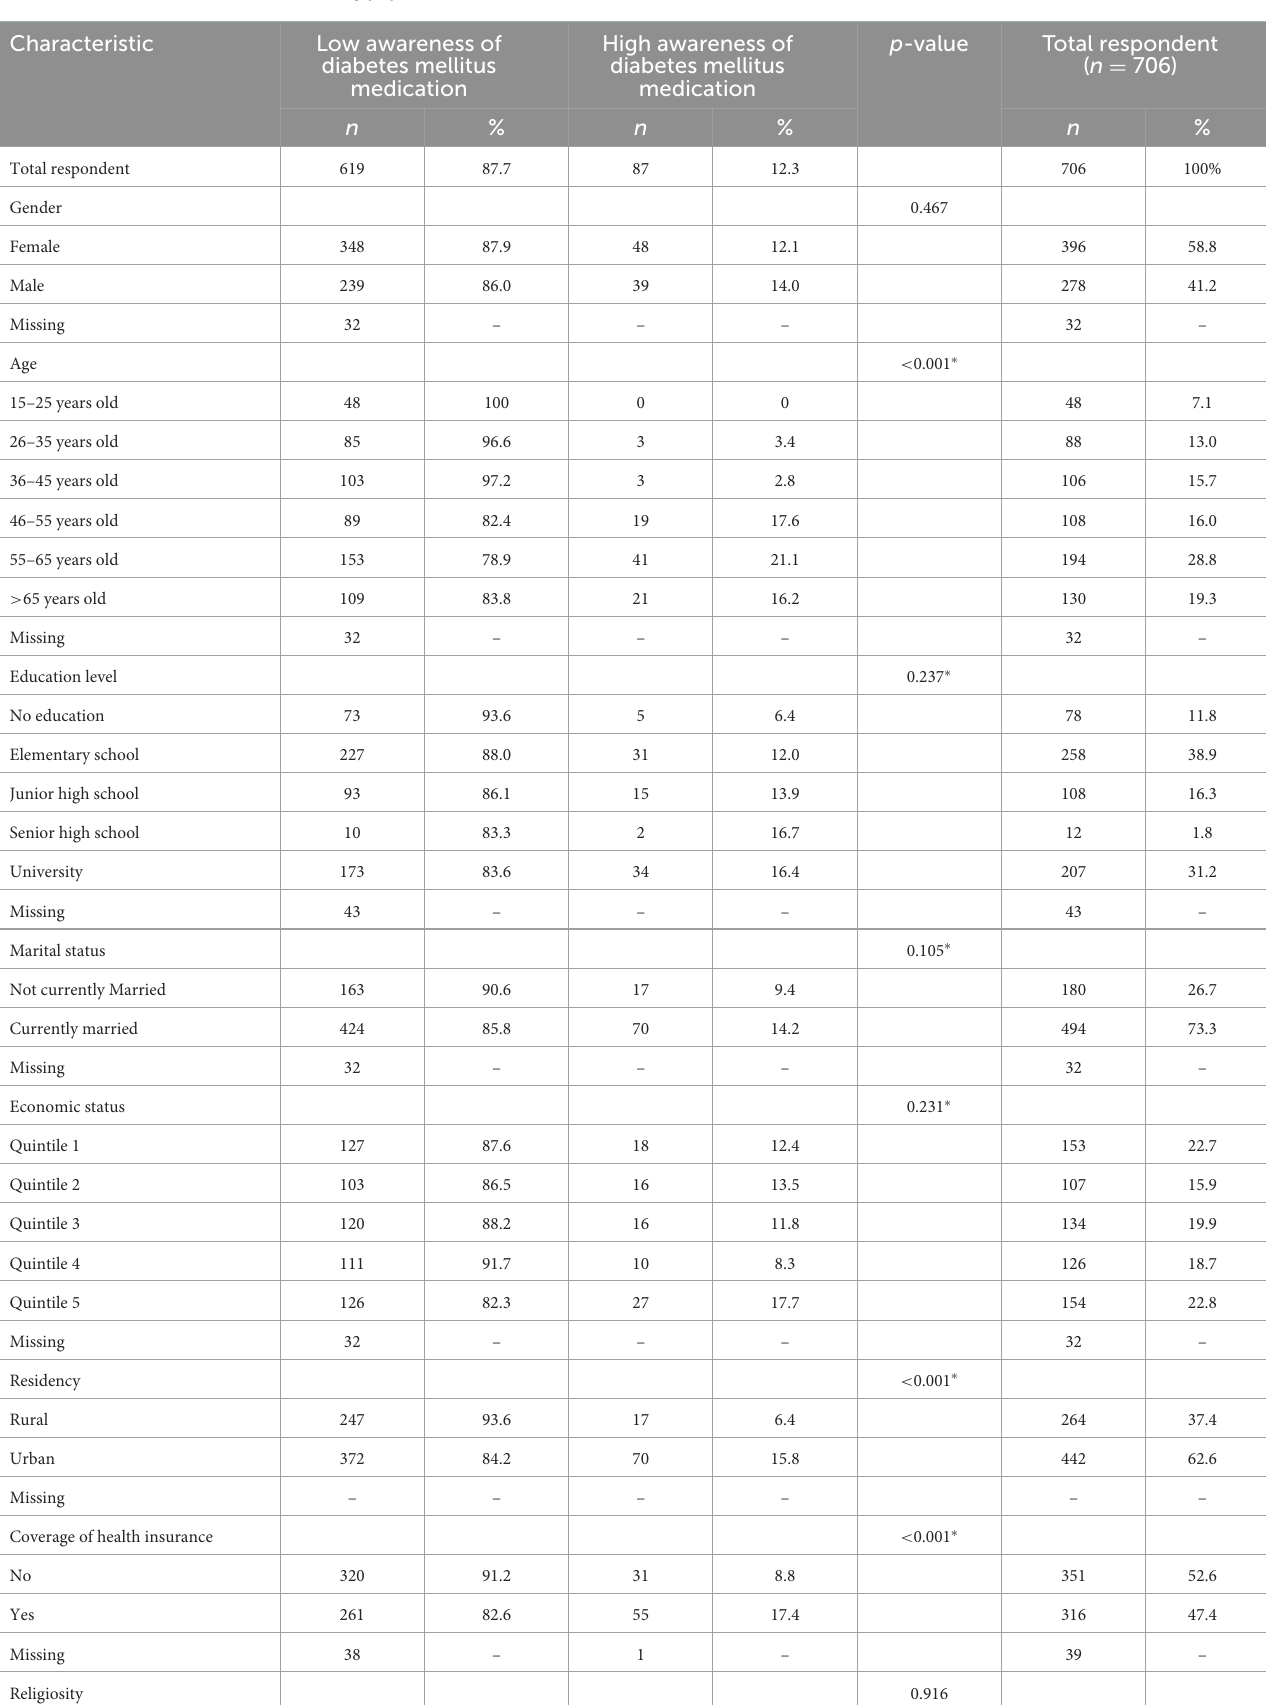
TABLE 1 Baseline characteristics of the study